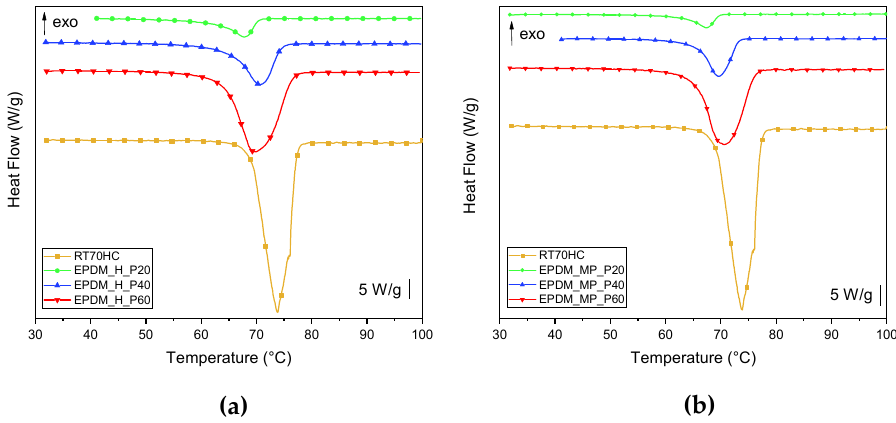
Figure 4. DSC thermograms (first heating scan) of neat paraffin (RT7OHC) and paraffin-filled foams produced with ( a ) H and ( b ) MP foaming agents. Table 7. Results of the DSC tests on neat paraffin and on the prepared